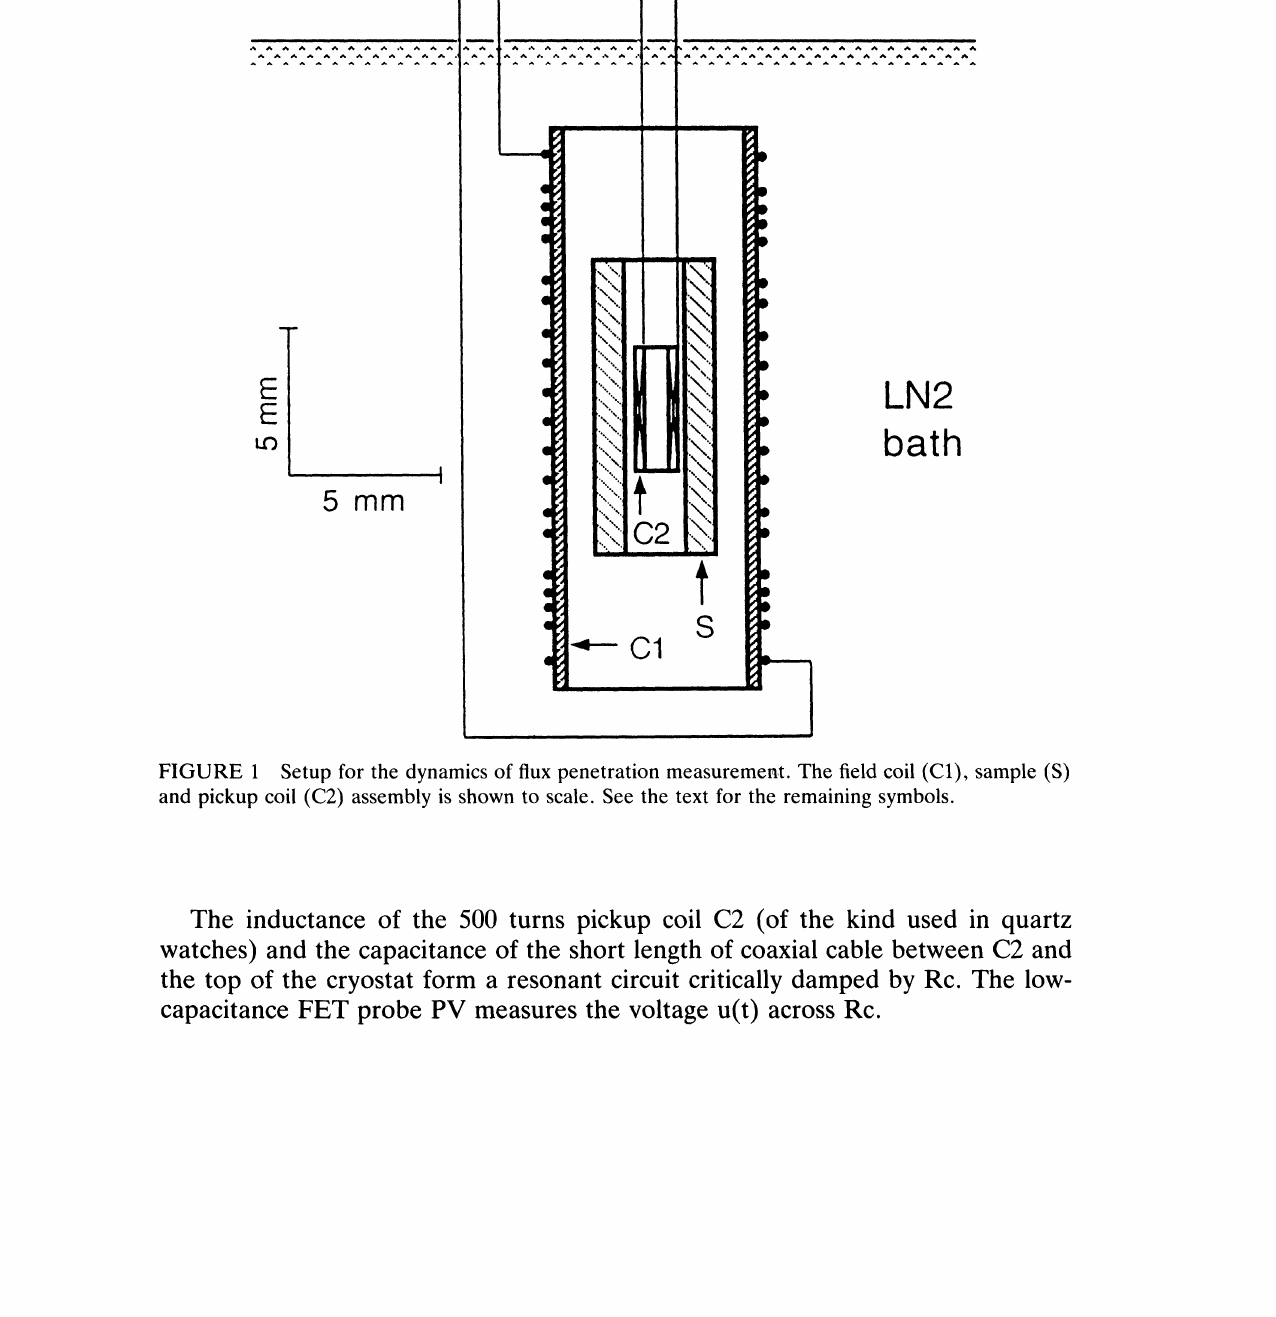
The inductance of the 500 turns pickup coil C2 (of the kind used in quartz watches) and the capacitance of the short length of coaxial cable between C2 and the top of the cryostat form a resonant circuit critically damped by Rc. The low- capacitance FET probe PV measures the voltage u(t) across